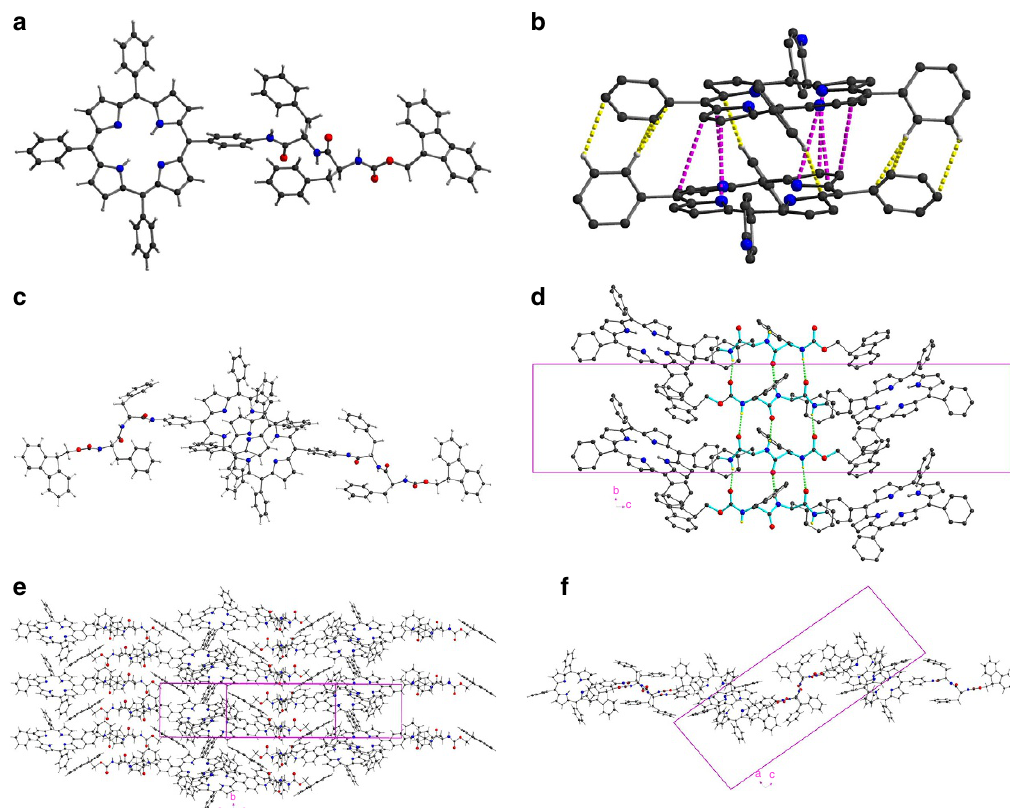
Figure 6 | Single-crystal X-ray structure of Fmoc-F L F L -TPP. ( a ) Molecule 1. ( b ) Dimer formed between Molecules 1 and 2 with an enlargement of the two porphyrin moieties (their Fmoc-F L F L units are omitted for clarity) showing C–H (cid:2) (cid:2) (cid:2) C interactions in yellow and p – p interactions in purple. ( c ) Another view of this dimer, perpendicular to the porphyrin planes, showing the slipped face-to-face geometry typical to p -stacking in porphyrinic J -aggregates. ( d ) Intermolecular ‘ b -pleated sheet’ hydrogen bonding (shown as green dashed lines) between -F L F L - moieties (highlighted in cyan) forming stacks in the b direction. The shifts of the IR frequencies to lower wavenumbers observed in the FT-IR spectra are thus fully accounted for. ( e ) Interdigitation of porphyrin groups between the b -pleated stacks forming layers parallel to [102], viewed projected onto [102]. ( f ) as ( e ) but viewed down the b -axis. Other views are presented in Supplementary Figs 33 and 34 while a larger portion of the crystal lattice is shown in Supplementary Fig.